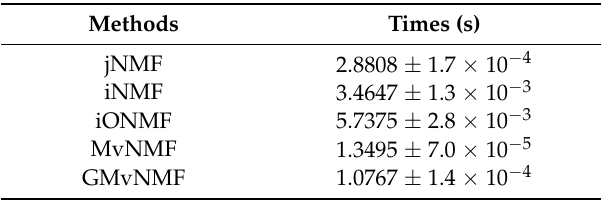
Table 2. Computational time on